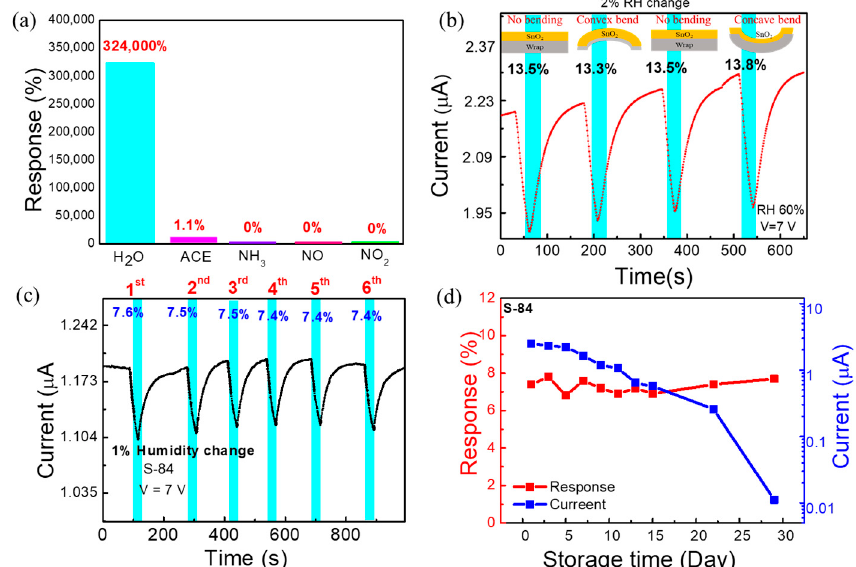
Figure 5. ( a ) Selectivity test under 1 ppm of different gases compared with 15–70% RH (H 2 O) ( b ) The real-time measurement of sensor at 2% RH change under different bending conditions (convex, concave, and no bending). ( c ) Repeatability test under 1% RH change. ( d ) Response and current data of S − 84 during 29 days of storage